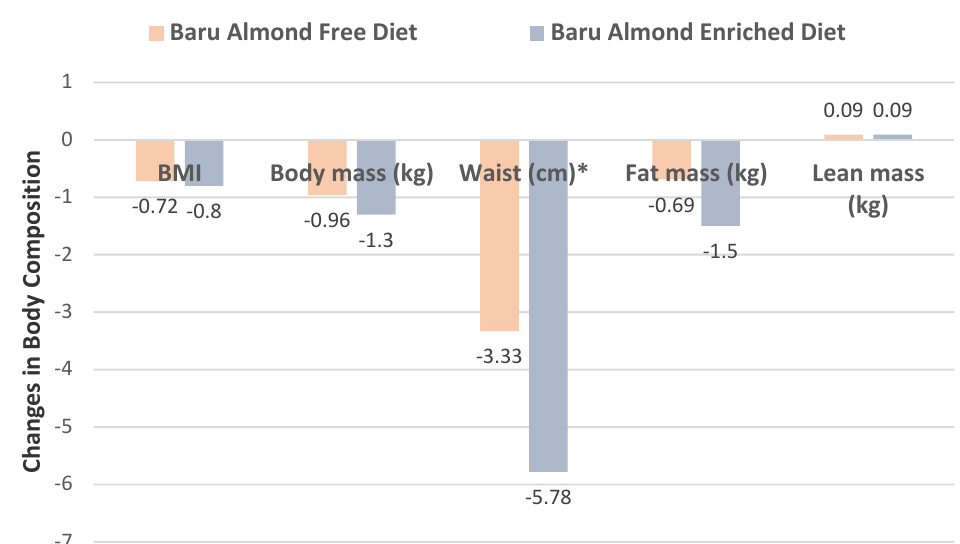
Figure 4. Change in body weight measures from baseline to 8 weeks for baru almond-enriched diets and control diets in overweight/obese women (* p = 0.03) [35]. Bento et al. [36], in a crossover RCT, randomized 20 mildly hypercholesterolemic subjects (8 men and 12 women, mean age 35 years, mean BMI 23) into their habitual diet plus 20 g (109 kcals) of baru almonds or a corn starch placebo capsule for 6 weeks. The baru almond-enriched diet tended to reduce body mass, BMI, and body fat (%) compared to the placebo (Figure 5).